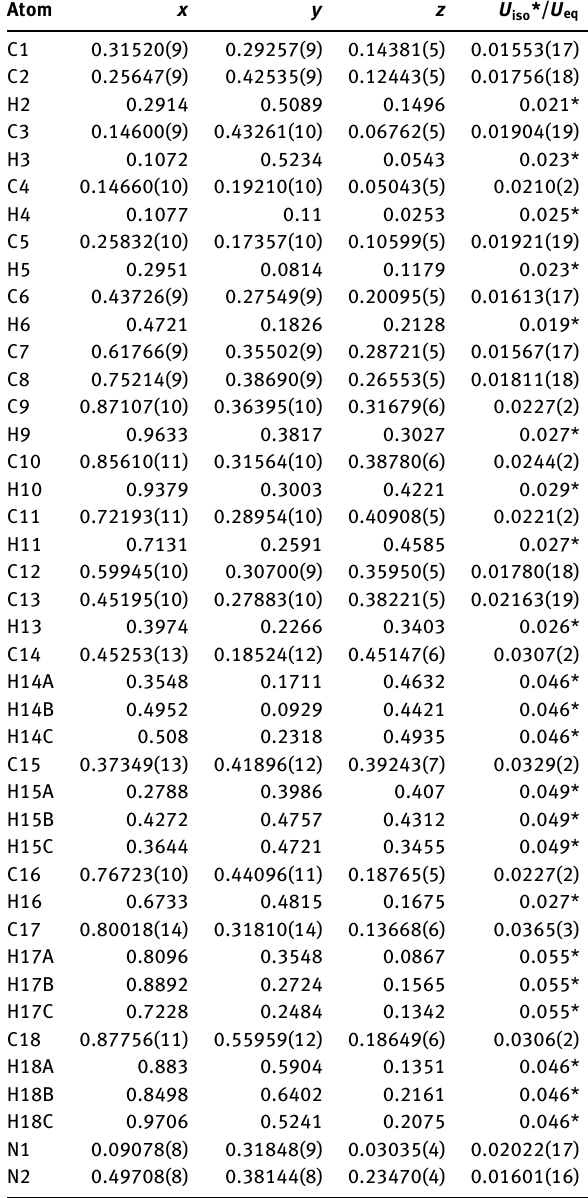
Table 2: Fractional atomic coordinates and isotropic or equivalent isotropic displacement parameters (Å 2